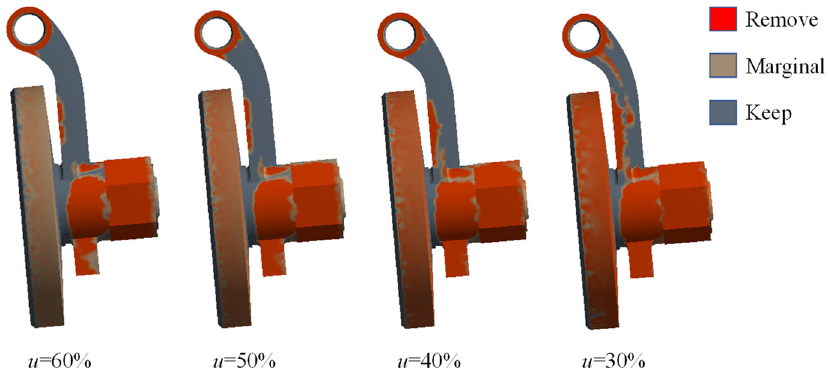
Figure 14. Compliance convergence curves.